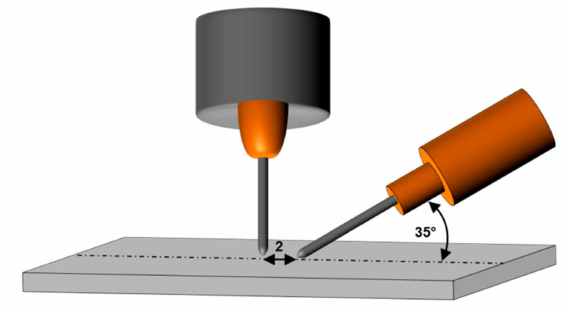
Figure 1. Setup and positioning of cold wire and electrode.